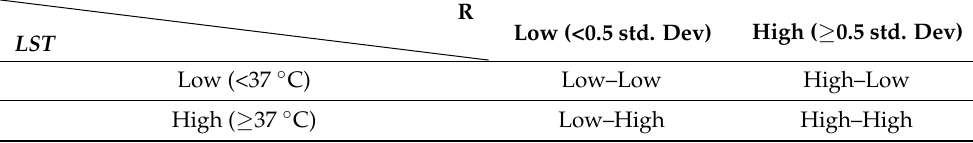
Table 3. Matching matrix of LST and sensitivity to